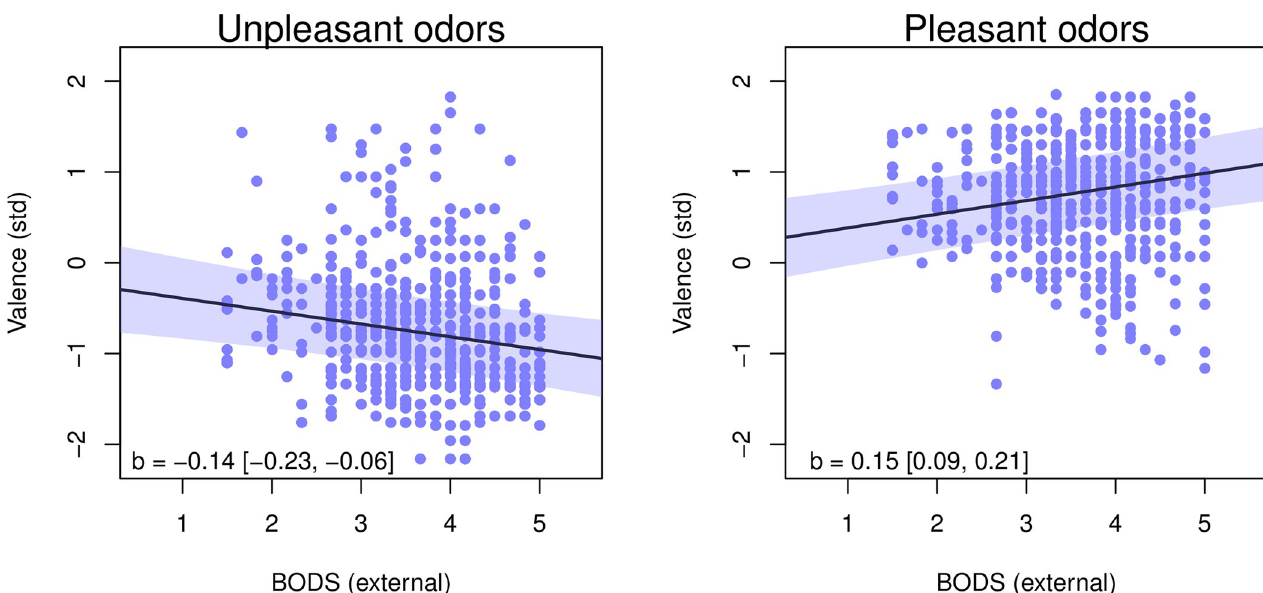
Fig 2. Relationship between external BODS and standardized valence ratings for unpleasant (left) and pleasant (right) odors. The shaded area and numbers in square brackets represent 94% HPDI for the slope.